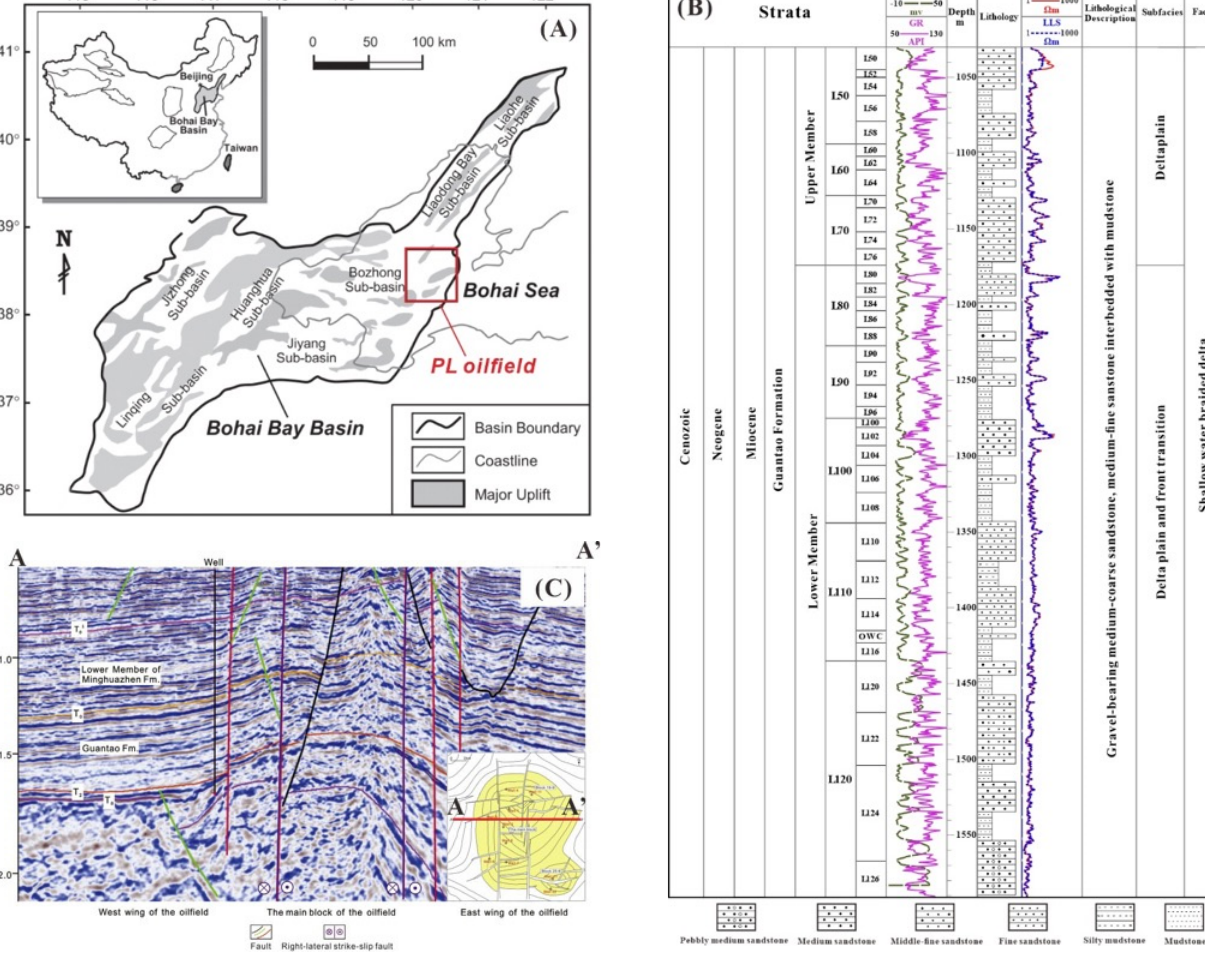
Figure 1. ( A ) The location of the PL Oilfield [30] . ( B ) The geologic column of the Guantao Formation in well PL19 − 3 − b. ( C ) PL: The E − W seismic profile of the PL oilfield is steep in the west and slow in the east [29] .